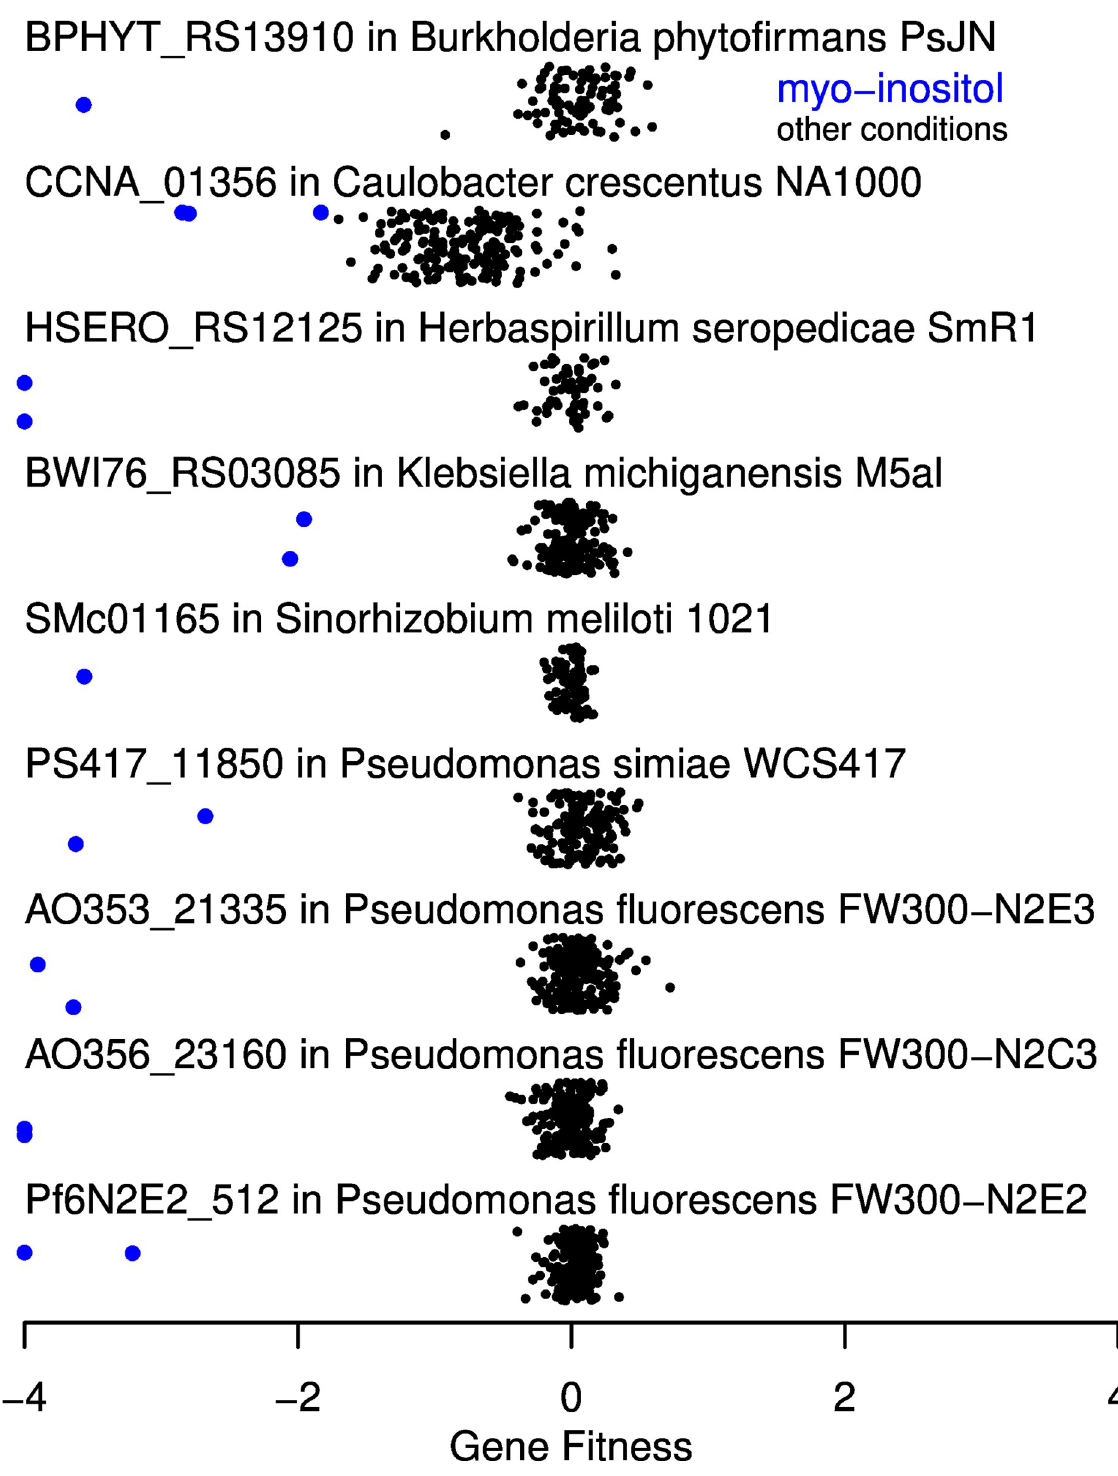
Fig 5. IolC-DUF2090 fusion proteins are important for myo-inositol utilization. Each point shows a gene fitness value ( x axis) from a separate experiment. Values under -4 are shown at -4. The y axis is arbitrary. Experiments with myo-inositol as the sole source of carbon are